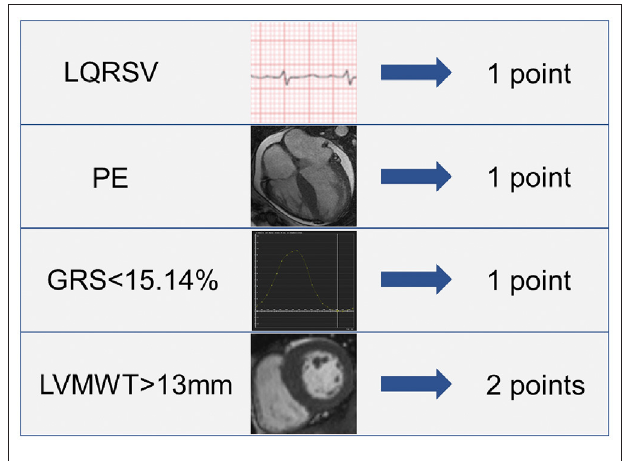
FIGURE 2 | Details of the risk score.